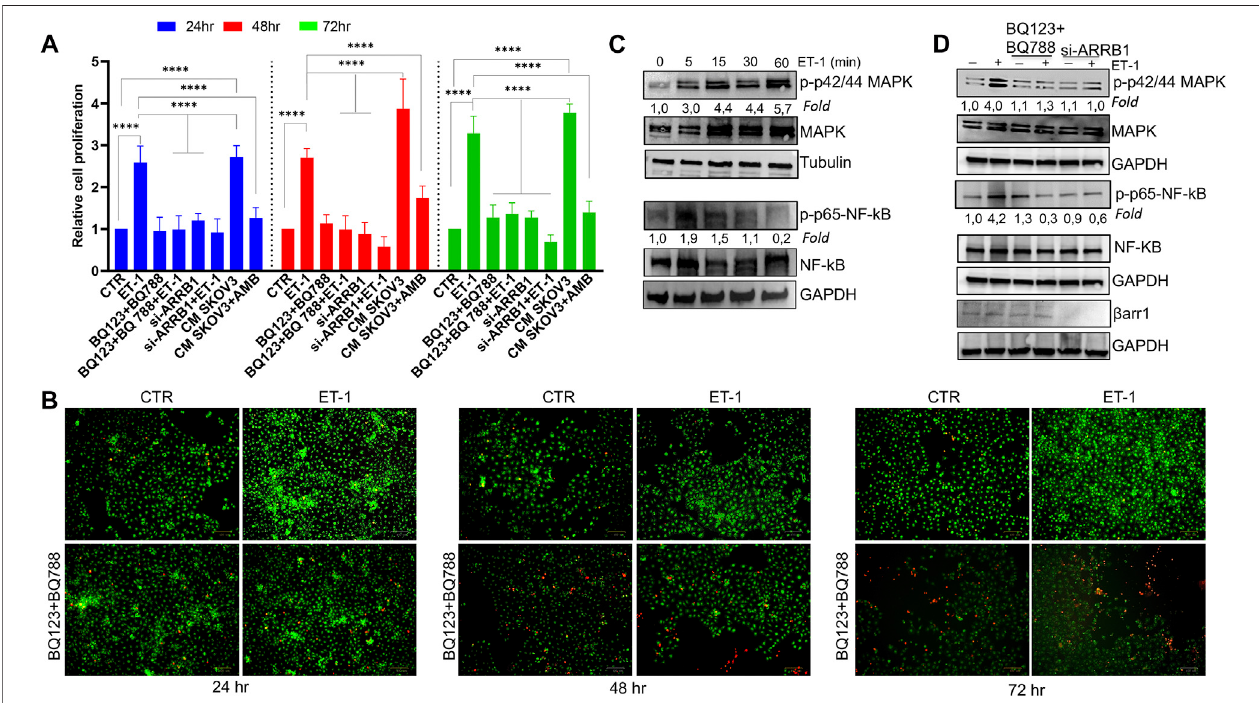
FIGURE 2 | ET-1 enhances MC proliferation through ET A R and ET B R and β arr1. (A) The relative proliferation of MCs untransfected or transfected, when indicated, with si-ARRB1 and treated with ET-1 and/or BQ123+BQ788 or with conditioned medium (CM) from SKOV3 untreated or treated with AMB at indicated time points. Histogram, the mean ± SD, n (cid:2) 6. One-way ANOVA. (B) Live-Dead images of MCs after ET-1 and/or BQ123+BQ788 treatment for the indicated times. Green stain, live cells; red stain, dead cells. Scale bar, 100 μ m. (C) Representative WB analysis of p-p42/44 MAPK/p42/44 MAPK and p-p65-NF-k β /p65-NF-k β levels in MCs stimulated or not with ET-1 for the indicated times. (D) Untransfected or si-ARRB1-transfected MCs stimulated with ET-1 and/or BQ123+BQ788 for 5 min were subjected toWB analysis forp-p42/44 MAPK/p42/44 MAPK and p-p65-NF-k β /p65-NF-k β levels. GAPDH or tubulin wasused asthe loading control. Phosphoproteins were normalized to the respective total proteins and indicated as fold-over